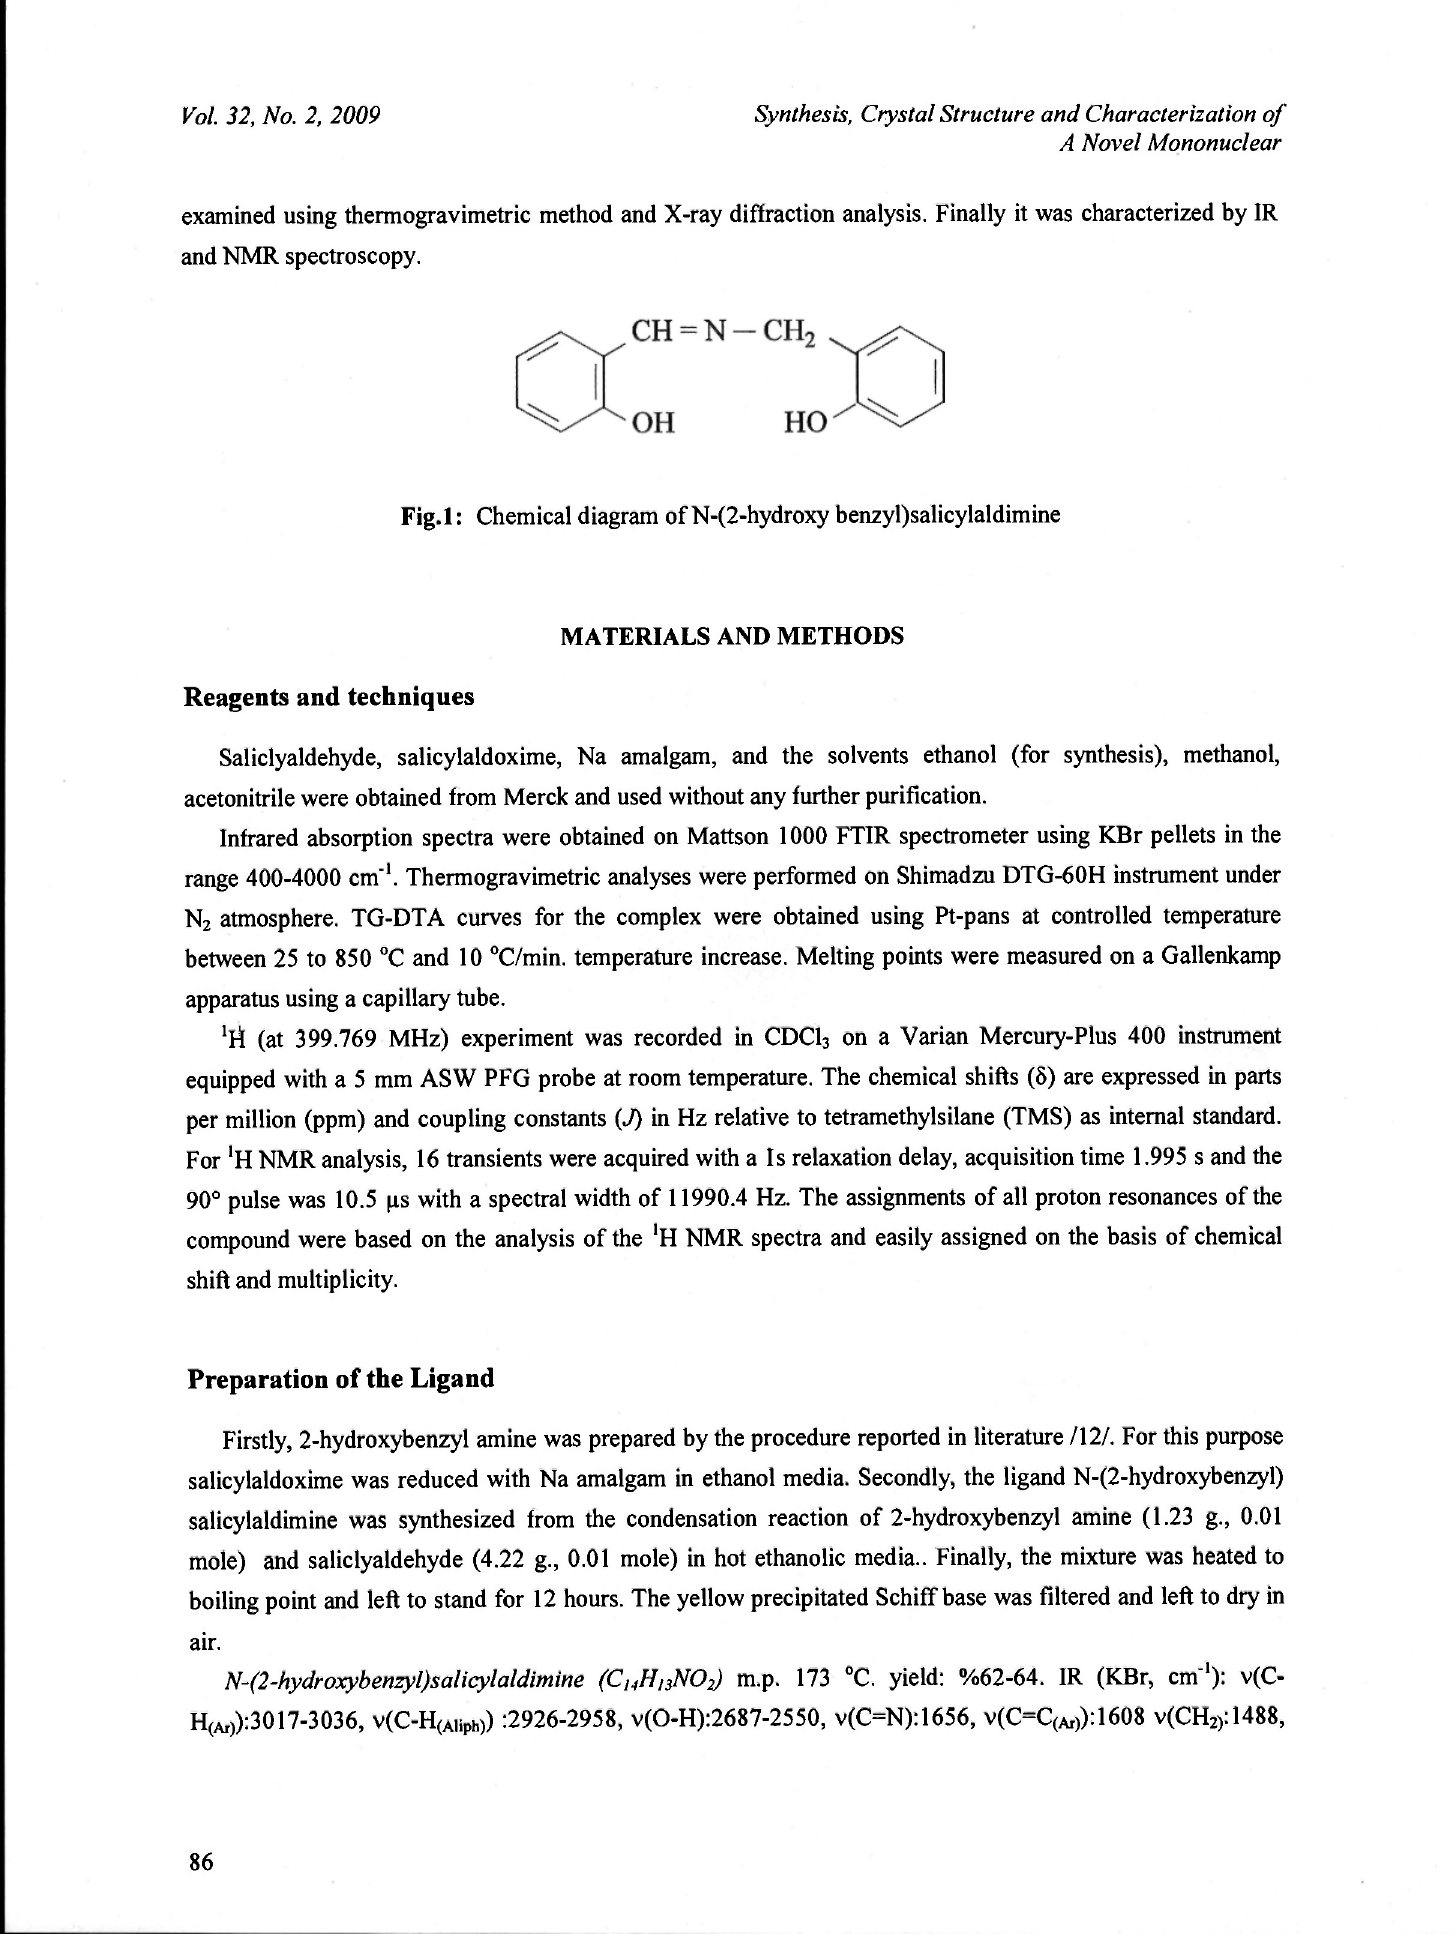
Fig.l : Chemical diagram of N -(2-hydroxy ben2yl